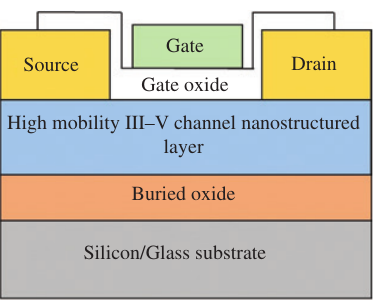
Figure 6: Cross-sectional schematic of a planar logic III–V